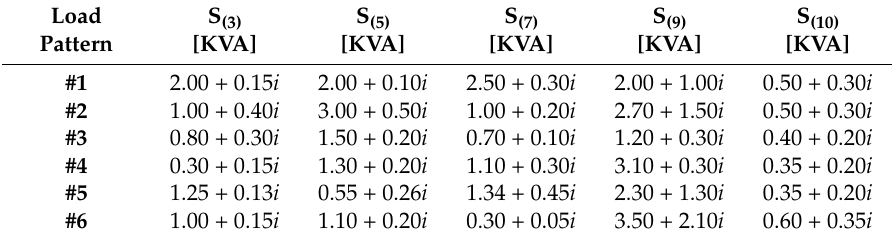
Table 1. Six load patterns at each node including active and reactive power.